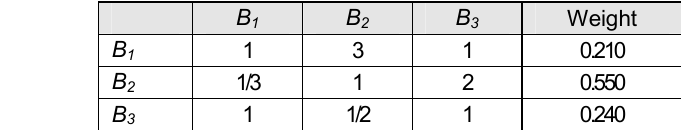
Table 11 – Matrix of the relevant importance of alternatives in relation to attribute A 6 (Force Protection) Таблица 11 – Матрица релевантной значимости альтернатив по